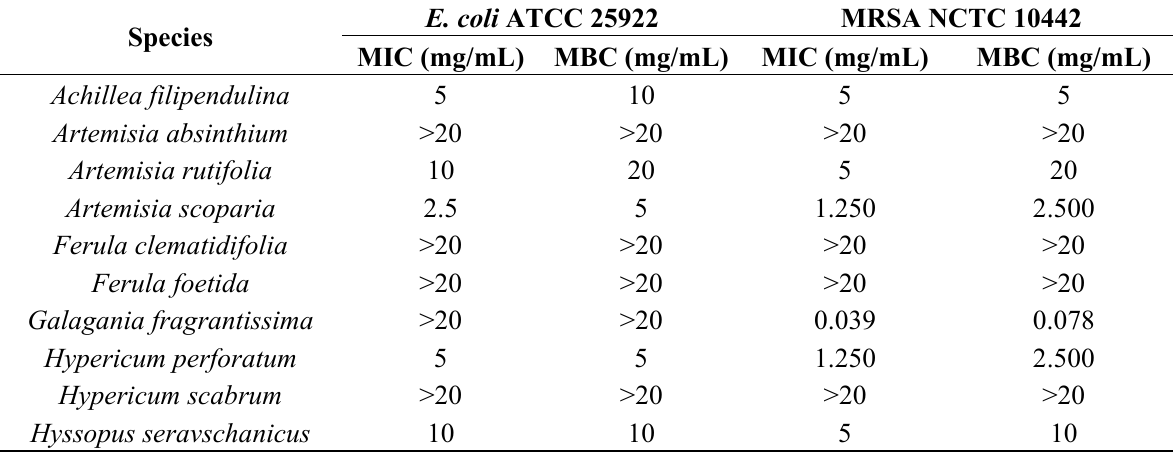
Table 2. Minimum inhibitory concentrations (MIC) and minimum bactericidal concentrations (MBC) of selected essential